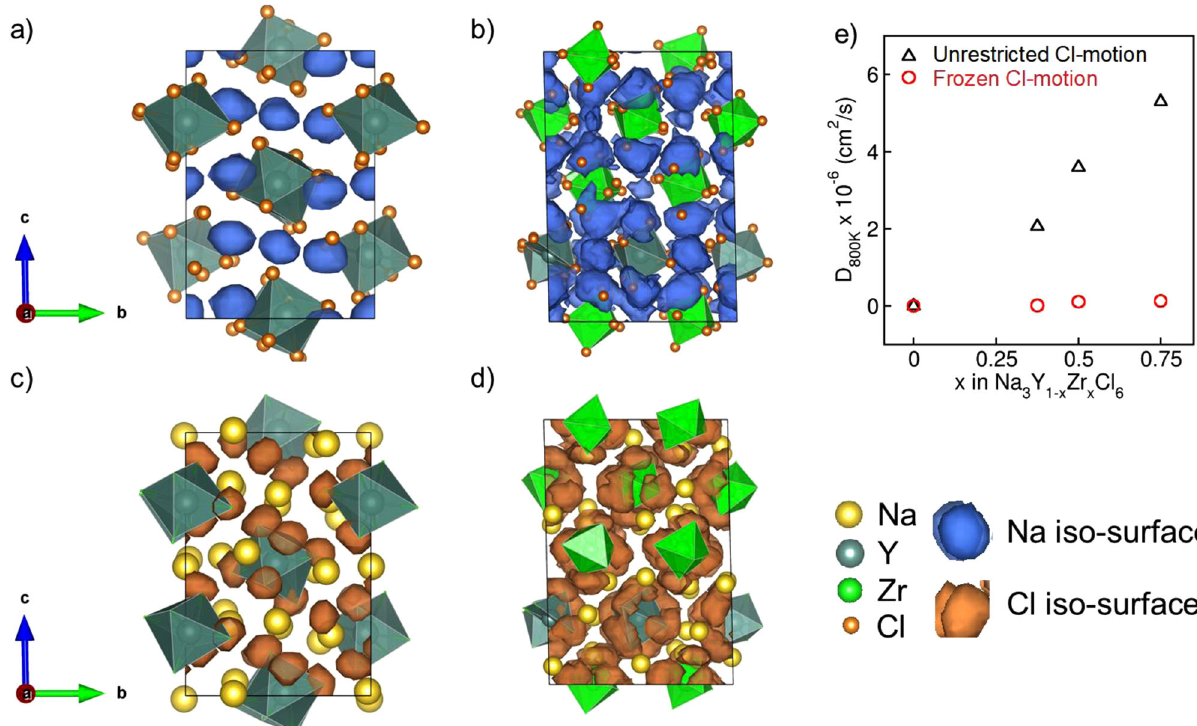
Fig. 4 Effect of octahedra rotation on Na + diffusivity. Plots of the probability density (isosurface value = 5 × 10 − 4 ) of a Na + in Na 3 YCl 6 , b Na + in Na 2.25 Y 0.25 Z 0.75 Cl 6 , c Cl − in Na 3 YCl 6 and d Cl − in Na 2.25 Y 0.25 Z 0.75 Cl 6 , over 100 ps of AIMD simulations at 600 K. The motion of Na + and Cl − in Na 3 YCl 6 are relatively localized, while macroscopic Na + diffusion with (Zr/Y)Cl 6 octahedral rotation are observed in Na 2.25 Y 0.25 Z 0.75 Cl 6 . e Na + diffusivity at 800 K (D 800K , in cm 2 /s) for varying Zr content in Na 3 − x Y 1 − x Zr x Cl 6 , compared with a selective dynamics simulation with Cl − ions frozen in space, which shows negligible Na +